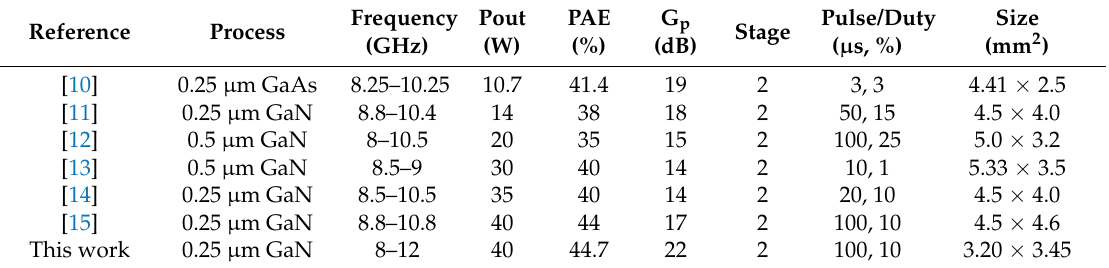
Figure 8. ( a ) Measured output power, gain, and PAE versus frequency at 24 dBm input power; ( b ) Measured S-parameter versus frequency; ( c ) Measured output power, gain, and PAE versus input power at 8.8 GHz frequency; ( d ) Measured output power, gain, and PAE versus input power at 10.4 GHz frequency. Table 2. Performance comparison of relevant power amplifiers.